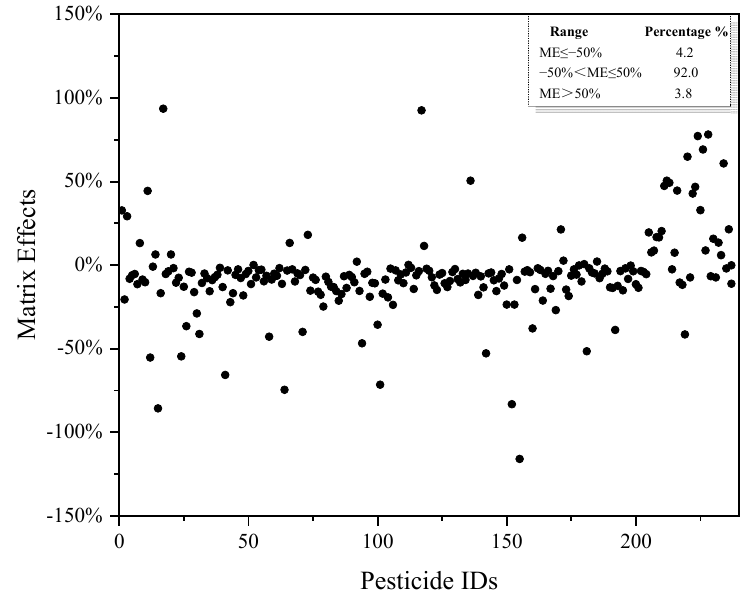
Figure 5. Matrix effect distribution of 237 pesticides.